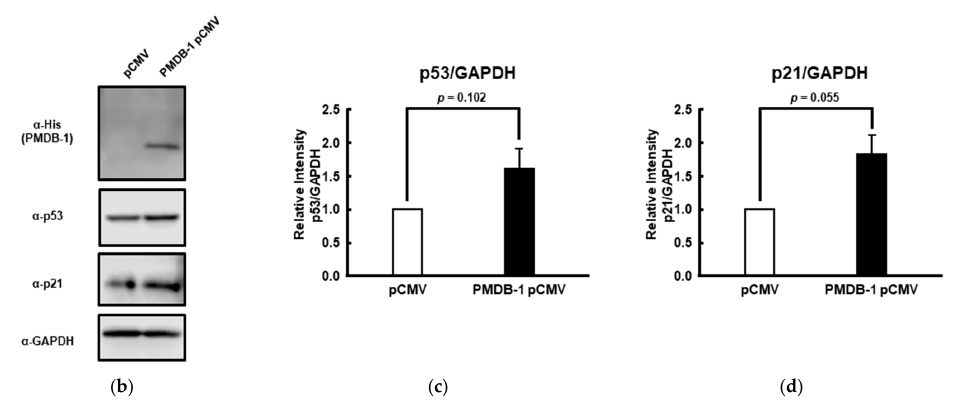
Figure 4. Biochemical function of B-loop-binding adnectin PMDB-1 in breast cancer-derived MCF- 7 cells: ( a ) subcellular localization analysis of PMDB-1 adnectin and PPM1D in MCF-7 cells; PMDB- 1 adnectin and PPM1D in MCF-7 cells were analyzed with PMDB-1-mCherry (red) and EGFP- PPM1D430 (green). Nuclei are shown in blue fluorescence by Hoechst33342; ( b ) Western blotting analysis of MCF-7 cells expressing PMDB-1 was performed using anti-His antibody to detect PMDB-1, and the inhibitory effect of PMDB-1 on PPM1D was evaluated by stabilization of p53 which is dephosphorylated and destabilized by PPM1D. GAPDH was detected by the anti-GAPDH antibody as an internal control protein. These experiments were performed as three independent experiments to confirm reproducibility; ( c ) quantitative evaluation of Western blotting analysis on p53 from three independent experiments; bar graphs show the means ± SDs; ( d ) quantitative eval- uation of Western blotting analysis on p21 from three independent experiments. Bar graphs show the means ± SDs.